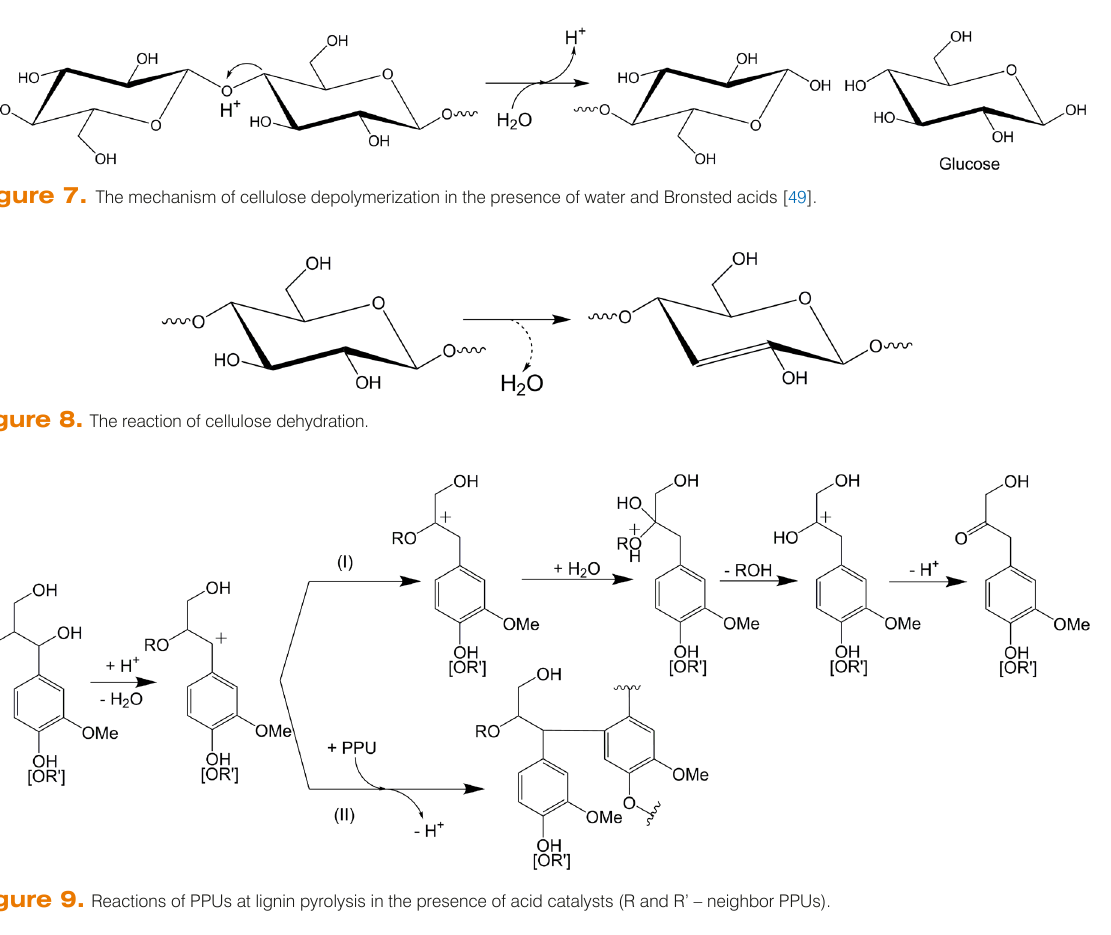
(Fig. 9 I) and condensation with formation of new C-C bonds between PPUs (Fig. 9 II) [ 13].